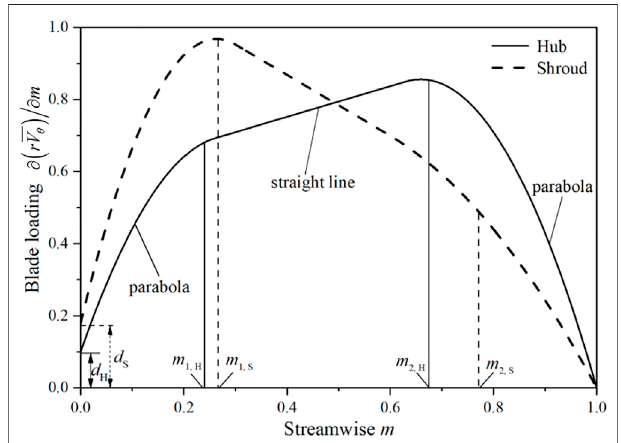
FIGURE 8 | Loading distribution for impeller blade.